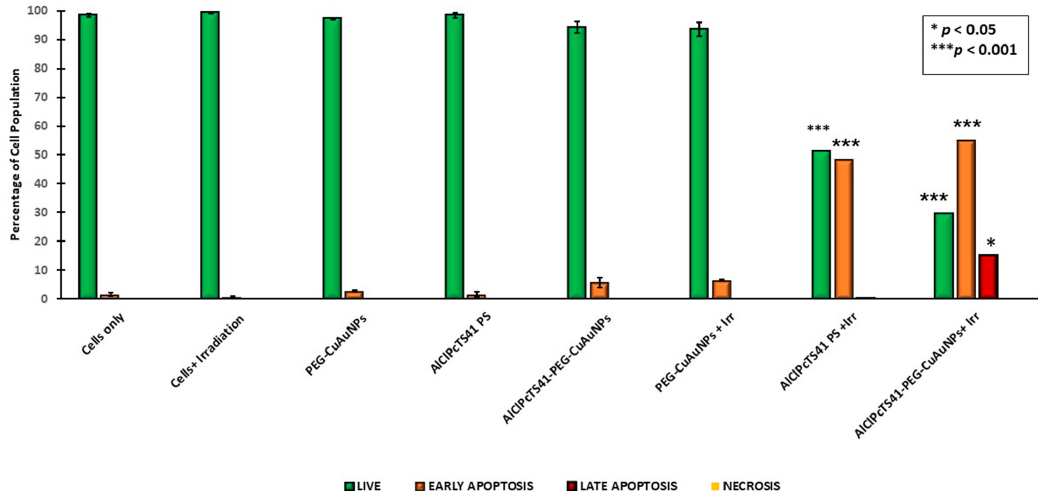
Figure 14. Apoptosis detection in Caco2 cells, determined by Annexin V-FITC and PI staining followed by flow cytometry analysis. Percentages of cell populations after treatment of Caco-2 cells are shown. (* p < 0.05, *** p < 0.001).